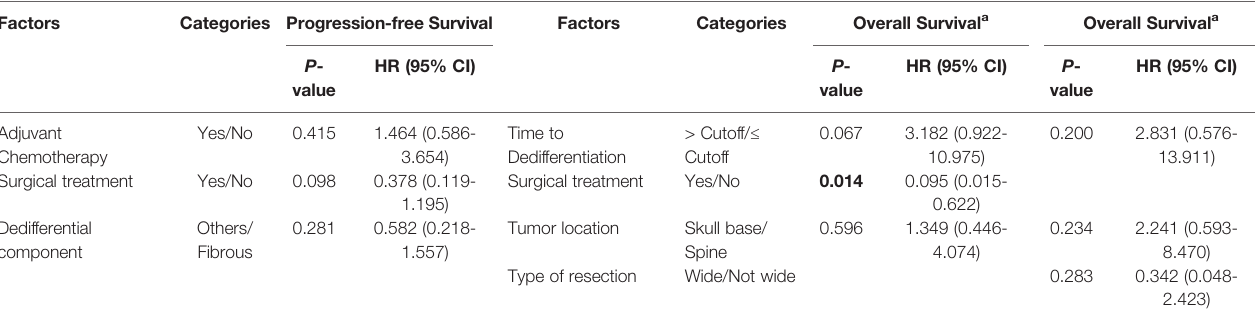
TABLE 5 | Multivariate Cox proportional hazard analyses of prognostic factors for progression-free survival and overall survival in patients with dedifferentiated chordoma. Factors